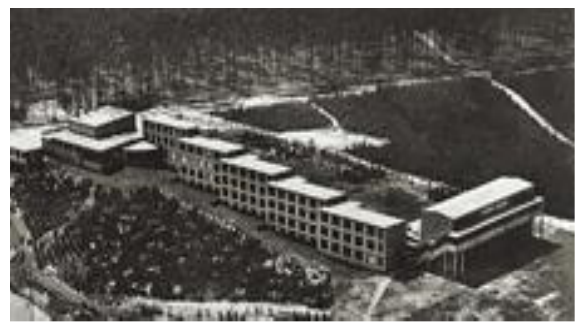
Figure 10. Hannes Meyer, Syndicate school of the ADGB in Bernau, aerial view by Junkers, 1928-30.